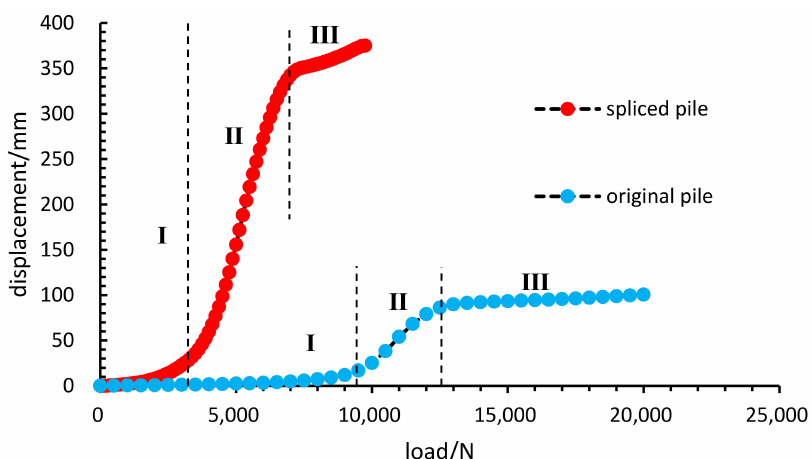
Figure 5. Load-displacement relationship curve of helical pile under lateral